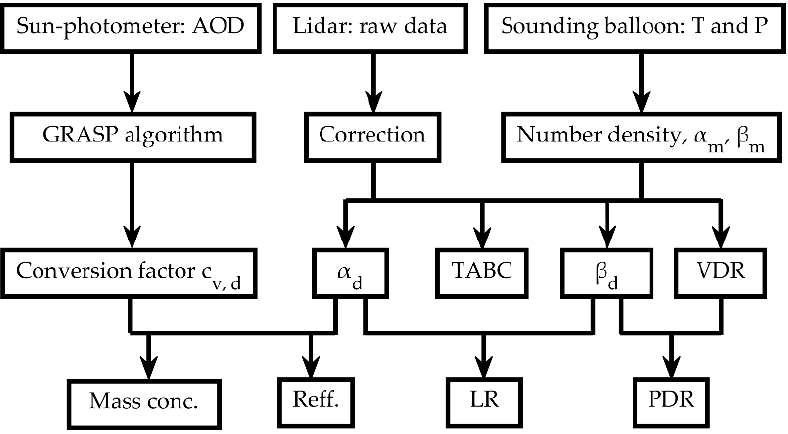
Figure 2. An overview of the data analysis scheme in this study.